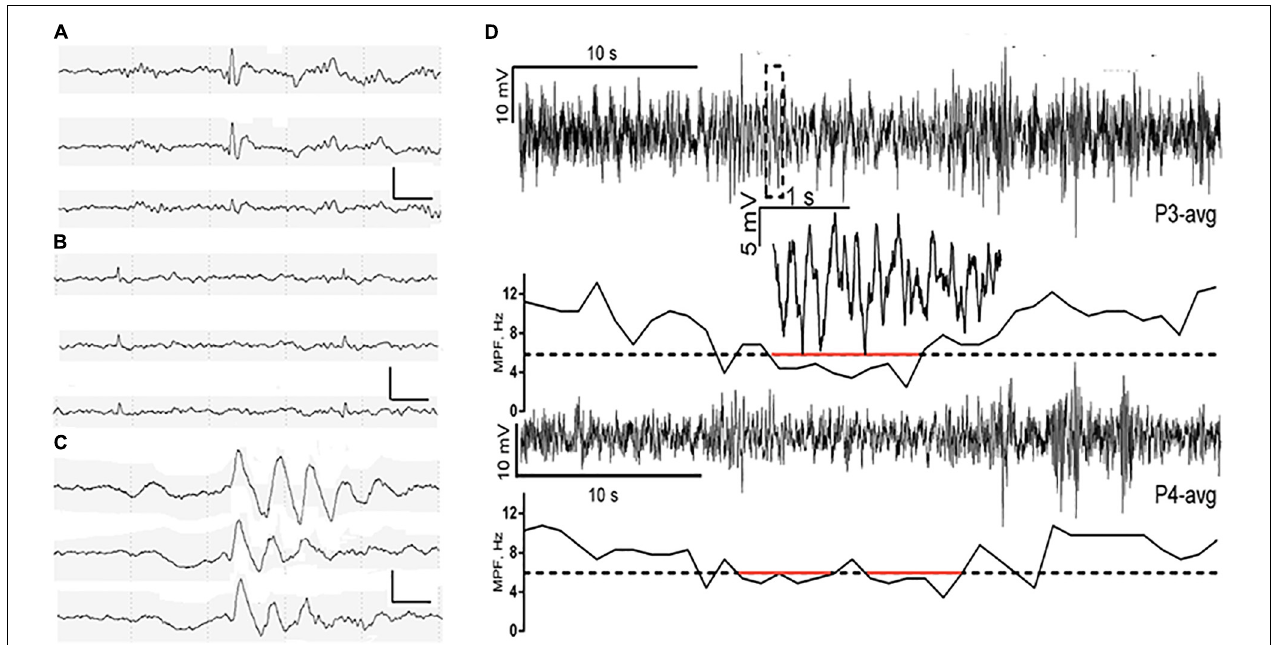
FIGURE 1 | Characterization of spike, small sharp spike (SSS), temporal intermittent rhythmic delta activities (TIRDA), and paroxysmal slow-wave event (PSWE). (A–C) Representative examples of spike, SSS, and TIRDA from the right temporal region in three patients with AD from our own ward, respectively. Scalp electrodes were placed using the international 10–20 system, sampling at 200 Hz. EEG channels (top to bottom): F8-ave, T4-ave, and T6-ave. Calibration bars: 100 µ V and 500 ms. (D) A PSWE detected in a patient with AD. Traces from electrodes P3 (upper trace) and P4 (averaged as reference) are shown. The segment within the dashed rectangle of P3 is shown magnified. The median power frequency is presented below each trace. Segments below 6 Hz (dashed line) are marked in red. From Milikovsky et al. (2019). Reprint with permission from The American Association for the Advancement of Science (AAAS).